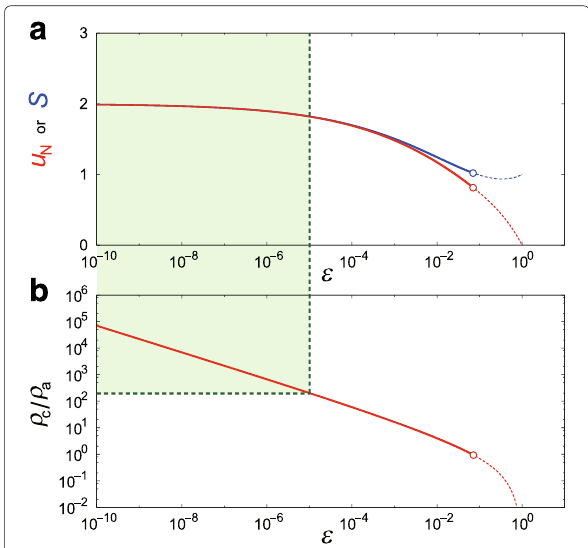
Fig. 5 Analytical solutions for the AB model during the slumping stage. a Front velocity u N ( redcurve ) and shock speed S ( bluecurve ), as functions of ε . b Relationship between ε and ρ c /ρ a , in which √ 2 (Benjamin 1968) is used. Dashedcurves represent the Fr = solutions for ρ c /ρ a <